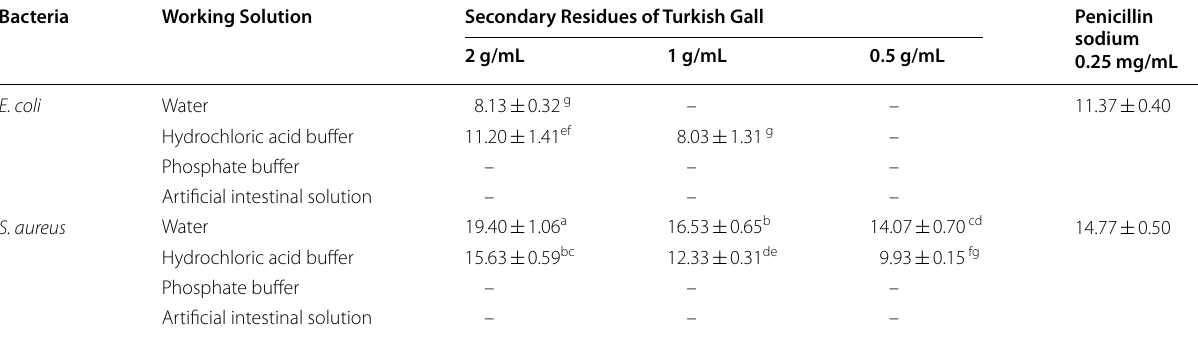
The diameter of the inhibition zone includes the diameter of the punched hole (6.0 mm). Different letters (a, b, c, d, e, f, g) indicate significant differences ( p < 0.05, Tukey test). – no inhibition zone formed